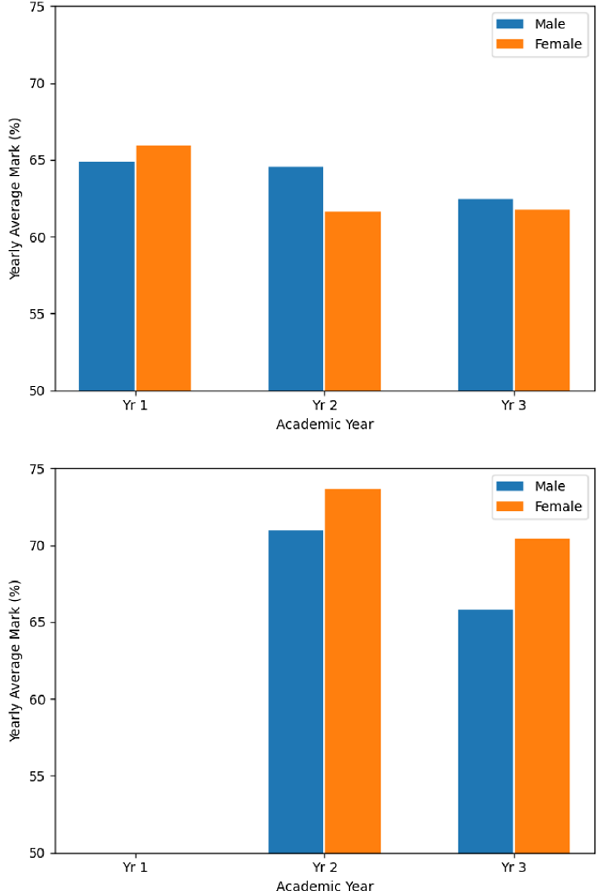
FIG. 3. Yearly average marks of male and female students per academic year for (a) first year entry cohort ( N ¼ 105 , Male ¼ 69 , Female ¼ 36 ), (b) direct entry cohort ( N ¼ 26 , Male ¼ 18 , Female ¼ 8 ). Note that there are no Yr 1 marks because this cohort enters directly into Yr